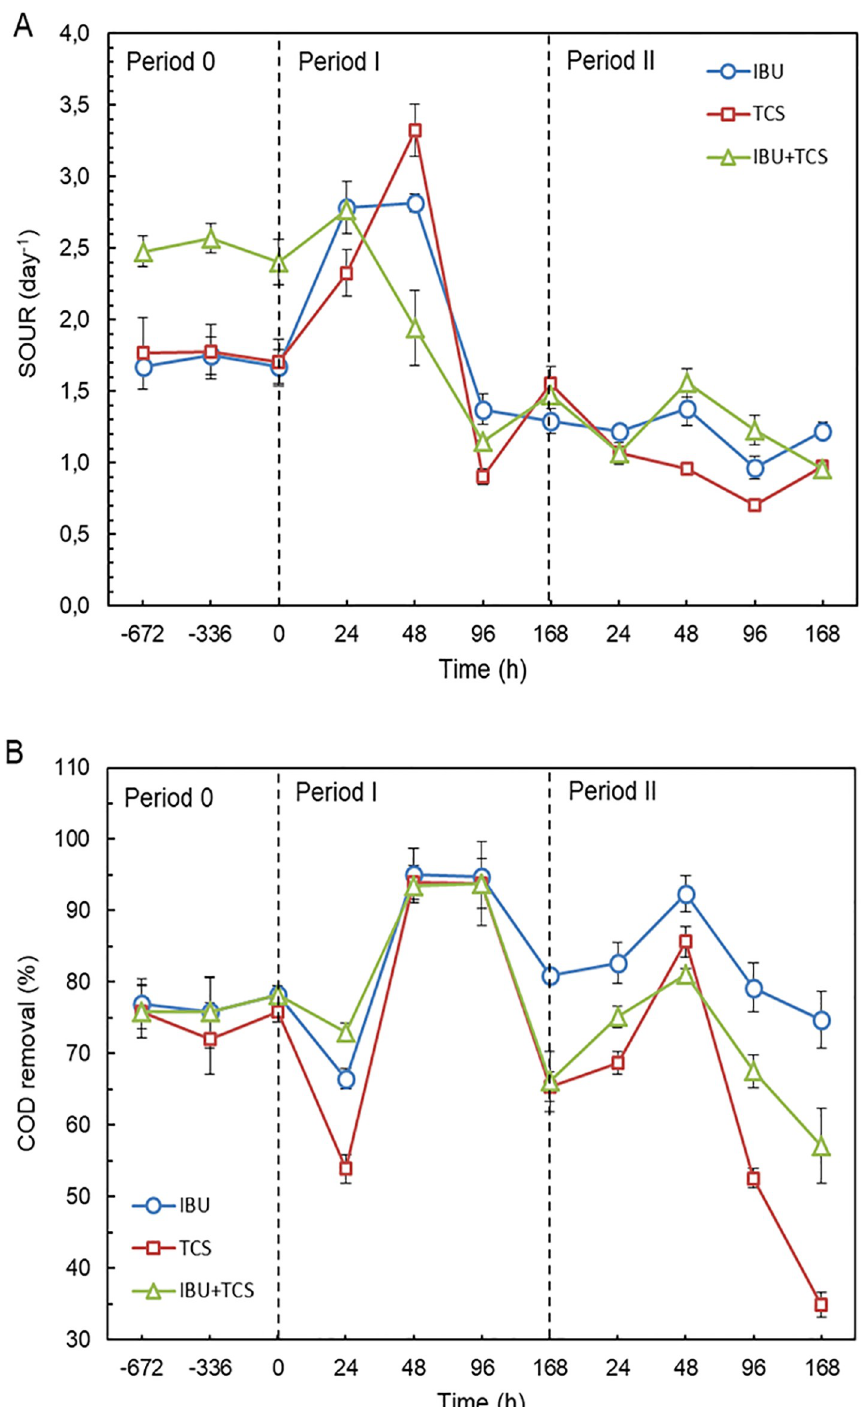
Fig 2. Effect of ibuprofen (IBU), triclosan (TCS) and their mixture on oxygen uptake (expressed as SOUR in day - 1 ) and chemical oxygen demand (COD) removal during 14-day assays. (Period 0 represents the stable operation prior to the introduction of